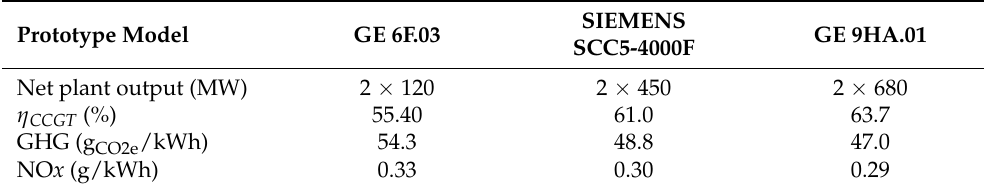
Table 6. Life cycle of GHG and NO x emissions of CCGT plants at three scales. Prototype